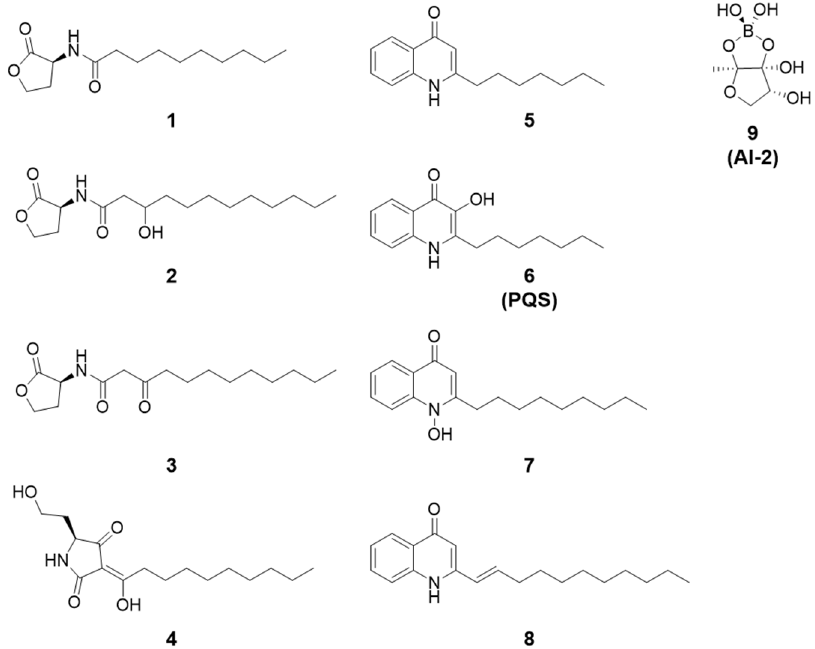
Figure 1. Representative compounds of relevant quorum-sensing signals. 1: C10-AHL, 2: OH-C12- AHL, 3: oxo-C12-AHL, 4: tetramic acid TA12, formed by spontaneous cyclization of oxo-C12-AHL, 5: heptyl-quinolone, 6: pseudomonas quorum signal (PQS) 2-heptyl-3-hydroxy-quinolone, 7: nonyl- quinolone-N-oxide, 8: 1 ′ E-undecenyl-quinolone, 9: furanosyl borate diester, AI-2.